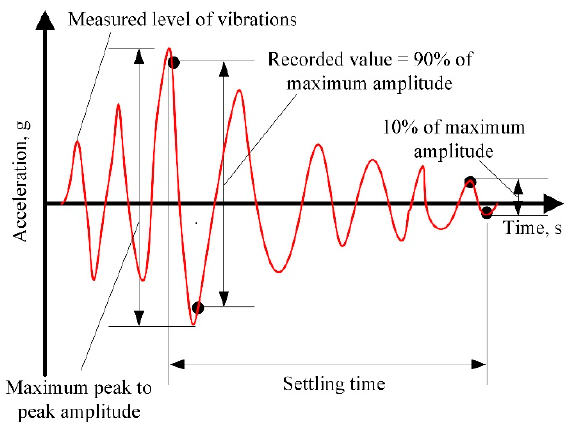
Figure 6. Flowchart of the vibration measurement process. Signals from three accelerometers were recorded continuously during robot move- ment between the endpoints of the trajectory. Later acquired data were processed offline (Figure 7), defining transient processes due to robot stops at the trajectory endpoints.